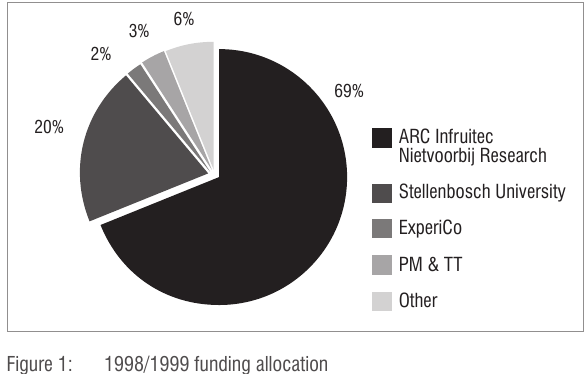
1998/1999 funding allocation